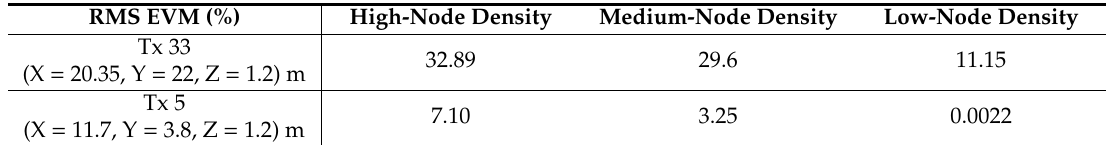
Table 2. Error vector magnitude (EVM) (%) for different nodes-density cases for the ZigBee system. RMS EVM (%) High-Node Density Medium-Node Density Low-Node Density Tx 33 (X = 20.35, Y = 22, Z = 1.2) m